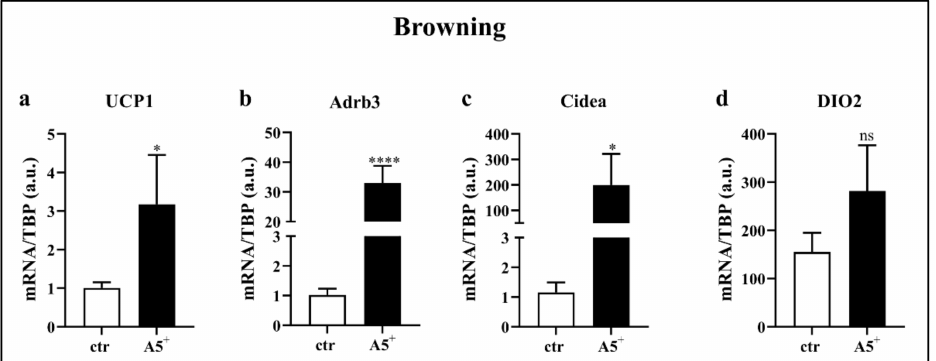
Figure 4. A5 + promotes browning related genes. Bar graph illustrating the most relevant browning- related genes modulated by A5 + administration: ( a ) UCP1, ( b ) Adrb3, ( c ) Cidea, ( d ) DIO2. Data are reported as mean ± SEM ( n = 4). (* p < 0.05; **** p < 0.0001). ctr: control; UCP1: uncoupling protein 1; Adrb3: β 3-adrenergic receptor; DIO2: Deiodinase, iodothyronine, type II. ns: not